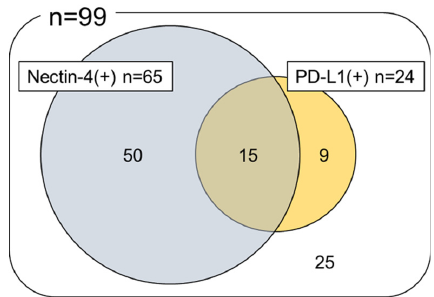
Figure 3. Association between the expression of Nectin-4 and Programmed Death Ligand 1 (PD-L1).